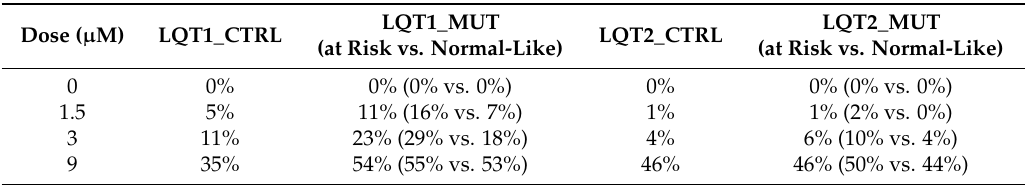
Table 4. Percent of models in each population showing abnormalities in response to increasing doses of quinidine. The values in brackets in the LQT1_MUT and LQT2_MUT columns represent the percent of models producing abnormalities in the at risk and normal-like groups in the respective mutant